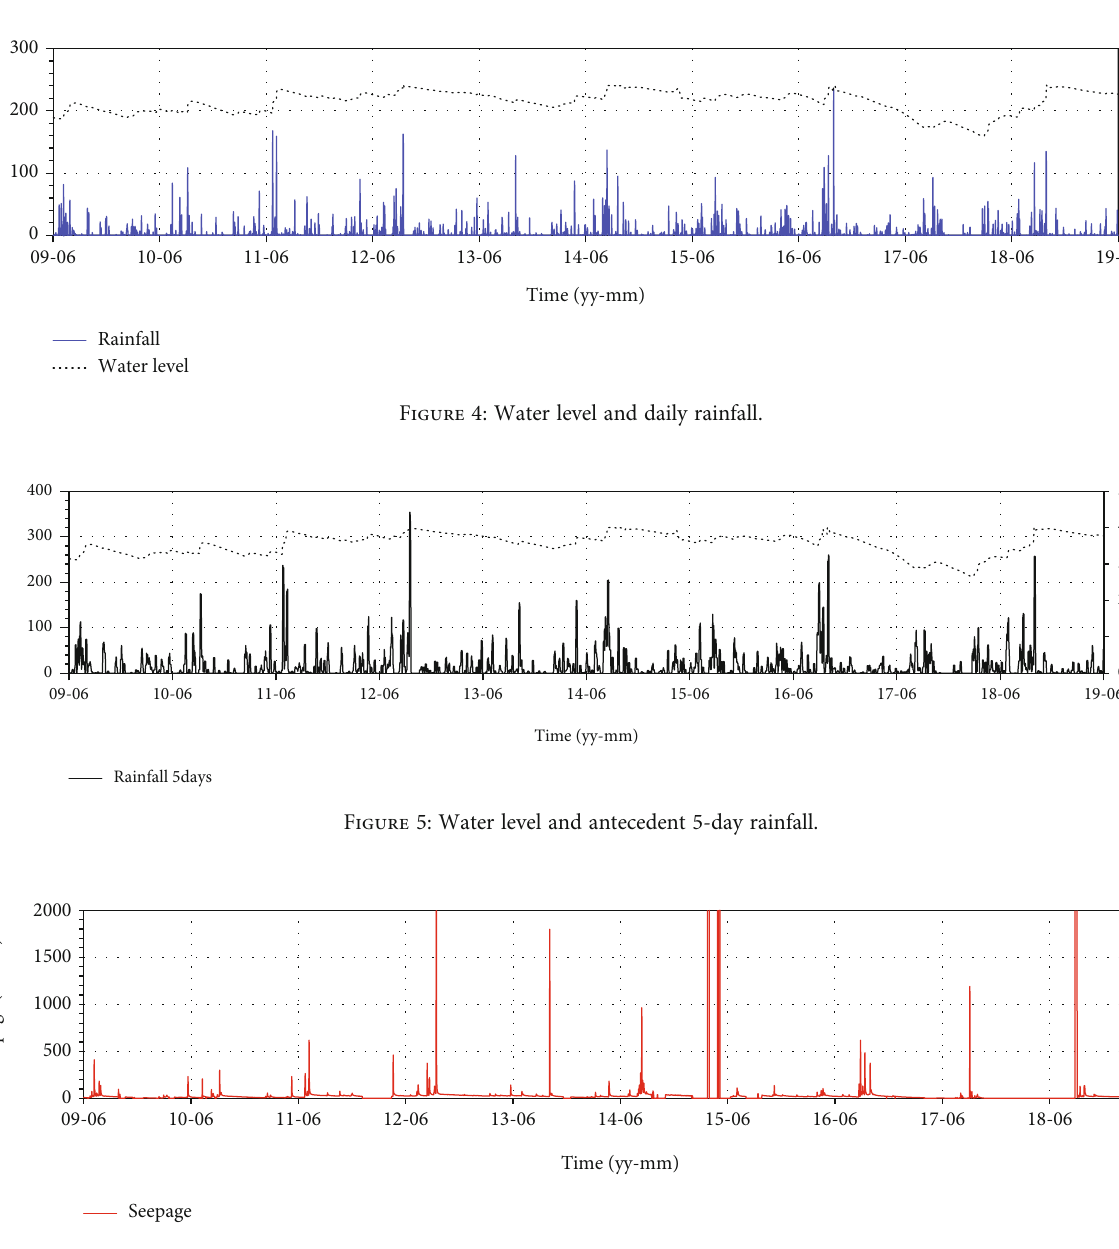
Figure 6: Seepage